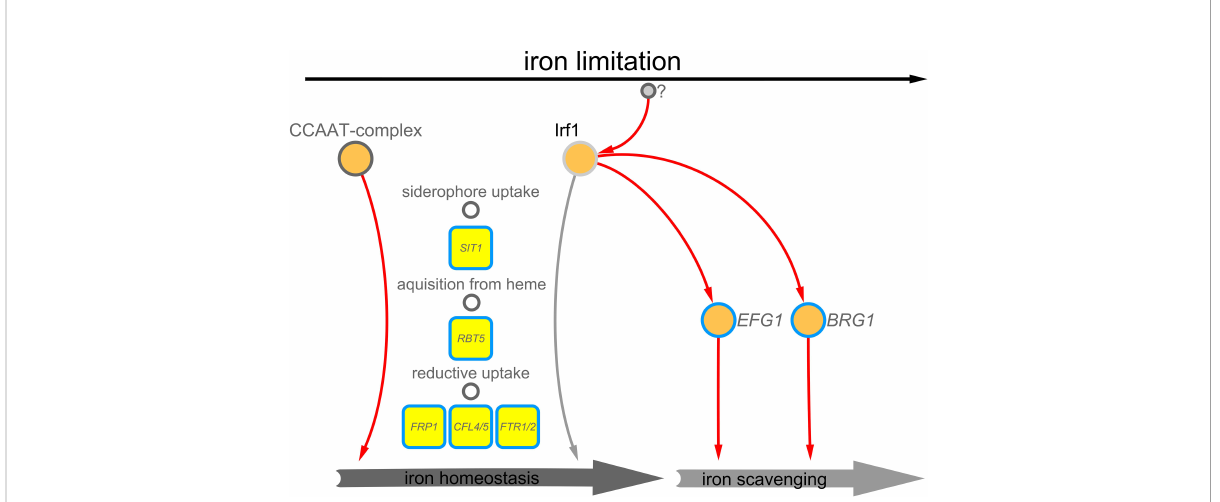
FIGURE 7 Working model – Irf1 functions at the interface of iron scavenging and iron acquisition. Irf1 is a transcription factor that is activated in iron de fi ciency, by yet unknown factors, and has a positive in fl uence on the expression of genes that are required for the uptake of iron, but also on genes that are important in the fi lamentation induced by iron de fi